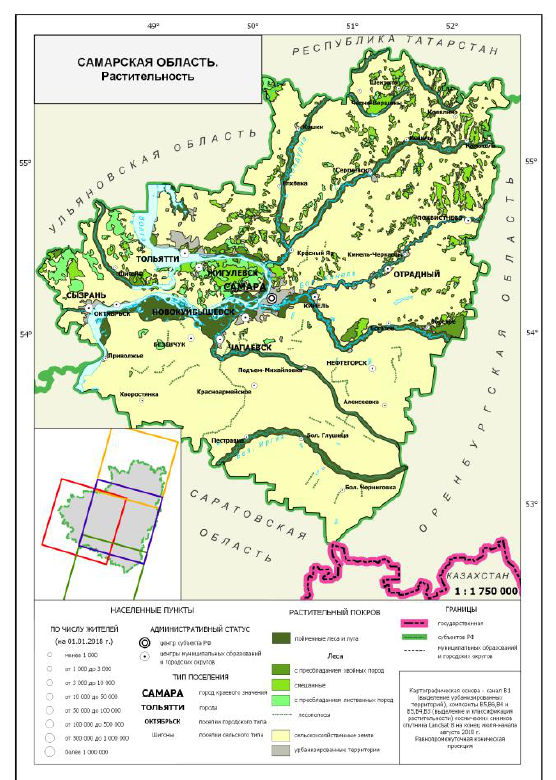
Figure 11. Final vegetation map of Samara Region (Russian